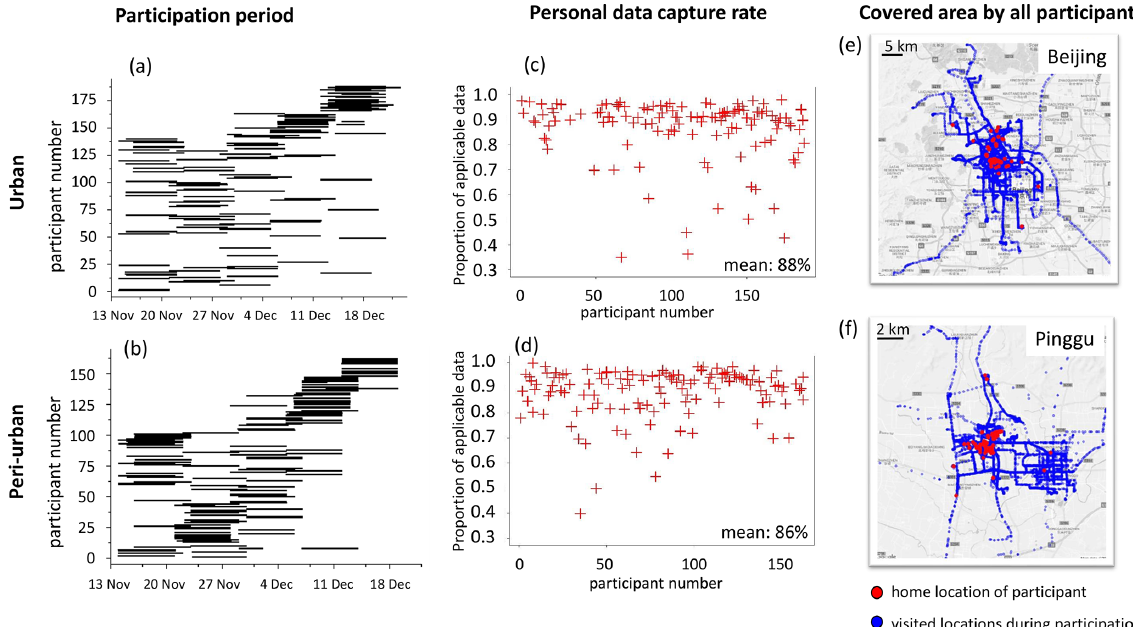
Figure 7. Participant compliance with the study protocol for personal exposure measurements during the winter season. Panels (a) and (b) show participant recruitment during the winter season at the urban and peri-urban sites. Each line represents start and end dates of an individual participant. Each week about 30 participants participated at each site. Panels (c) and (d) show personal data capture rate after appropriate data cleaning. At both sites we collected > 86% of theoretic observations. Panels (e) and (f) show GPS data of 251 participants carrying 60 PAMs plotted on urban and peri-urban maps (blue). Home locations (red) mined with the time–activity model. The figure is based on Google Maps © Google